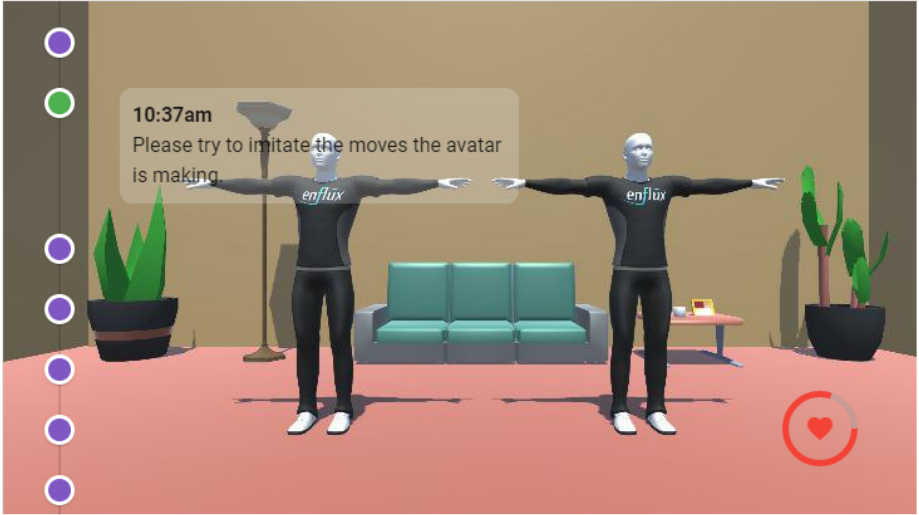
Figure 5. Virtual reality scenario.